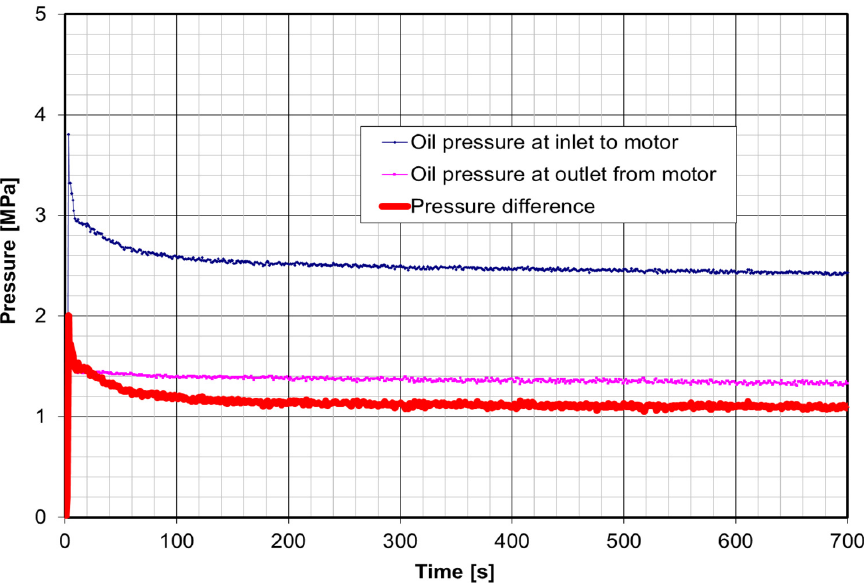
Figure 12. Characteristics of the oil pressure at the inlet and the outlet of the motor and the pressure difference as a function of time (ambient temperature (motor) − 6 ◦ C, oil temperature 44 ◦ C, obtained difference as a function of time (ambient temperature (motor) − 6 °C, oil temperature 44 °C, obtained rotational speed approximately 250 rpm). rotational speed approximately 250